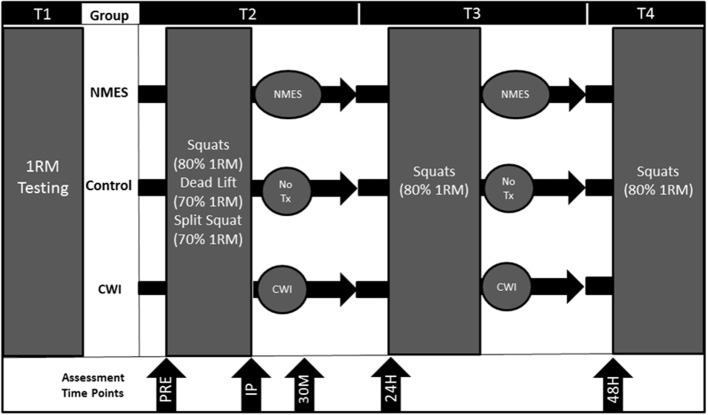
Study design for control (CON), neuromuscular electrical stimulation (NMES), and cold water immersion (CWI). PRE = Pre-exercise. IP = Immediately post-exercise. 30M = 30 min post-exercise. 24H = 24 h post-exercise. 48H = 48 h post-exercise. 1RM = 1-repetiton maximum. Tx = Treatment.